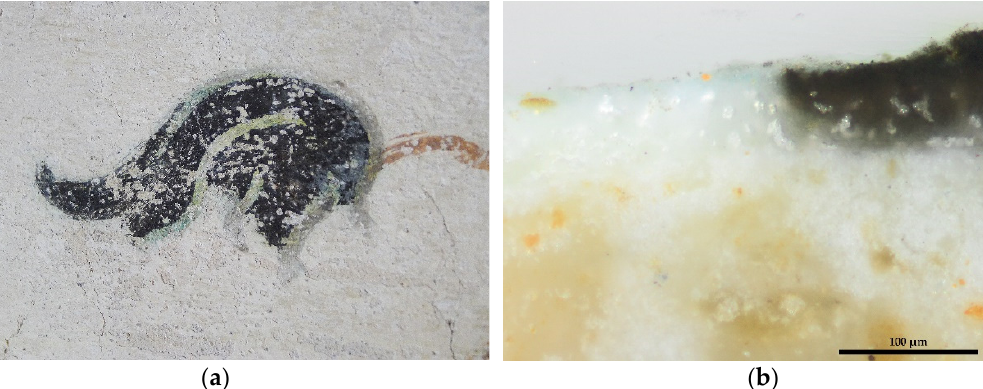
Figure 3. ( a ) Photo of the area where sample Ch35 was collected; ( b ) cross-section of sample Ch35 with a malachite layer, and tenorite as alteration product, magnification ×200.